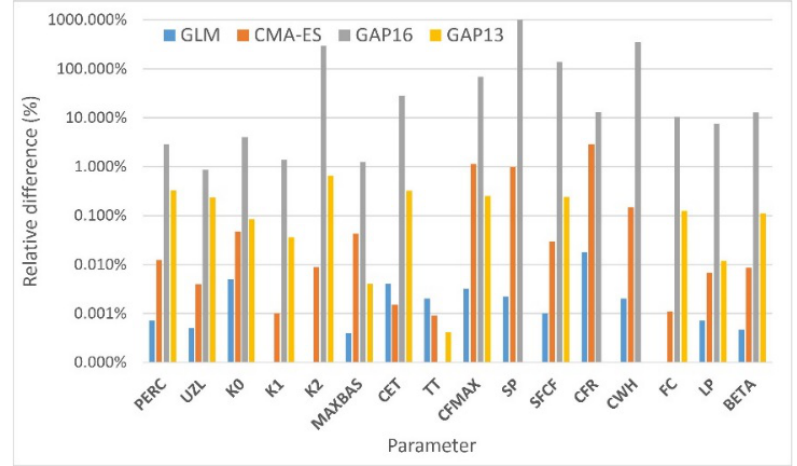
Figure 5. Graphical presentation of calibrated parameters with different optimizers.